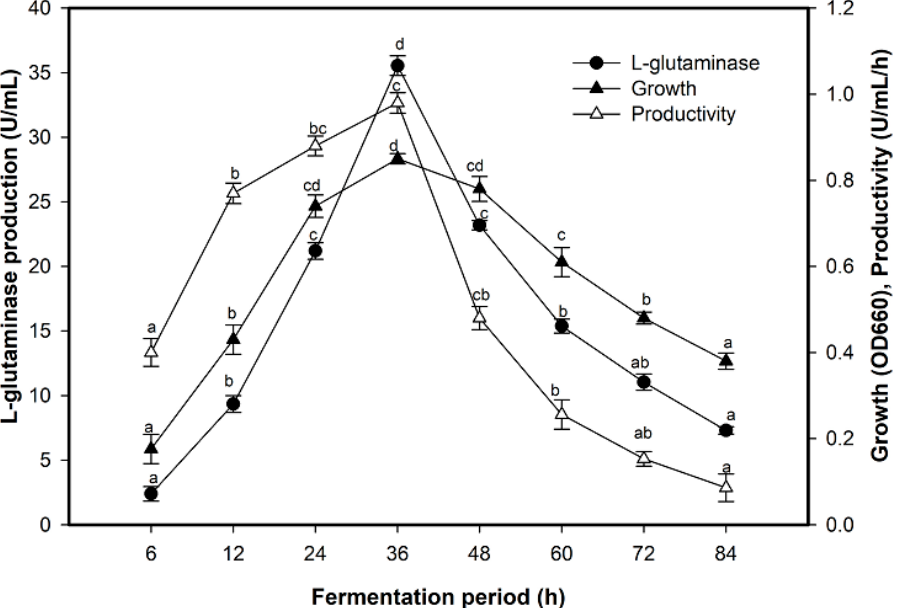
Figure 3. Time course of L-glutaminase production by Halomonas meridian . Mean ± standard error ( n = 3) is presented. Vertical bars indicate the standard errors of the means. Means followed by different letters are significantly different at p <